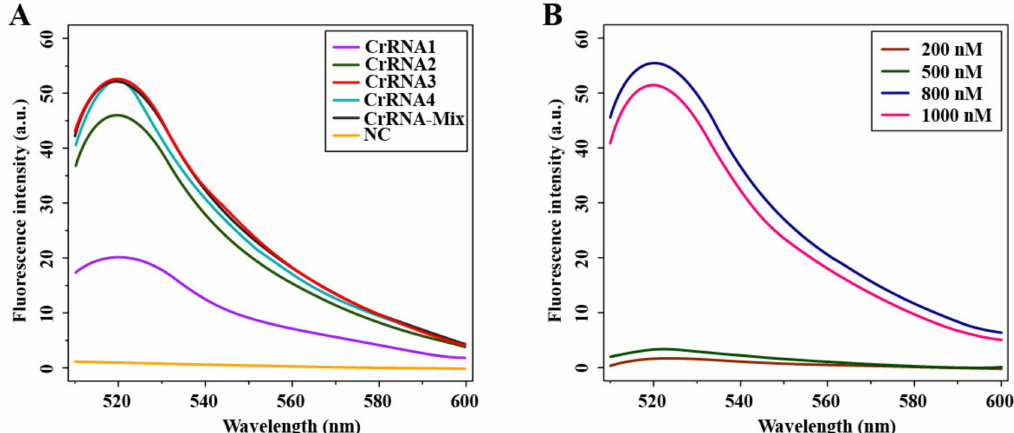
Figure 3. Optimization of the fluorescence detection of Cas12a. ( A ) Screening of the crRNA sequence. crRNA1, crRNA2, crRNA3 and crRNA4 represent different crRNAs; crRNA-MIX represents the product of the above four crRNAs mixed in the same proportion; NC stands for negative control. ( B ) Optimization of the concentration of